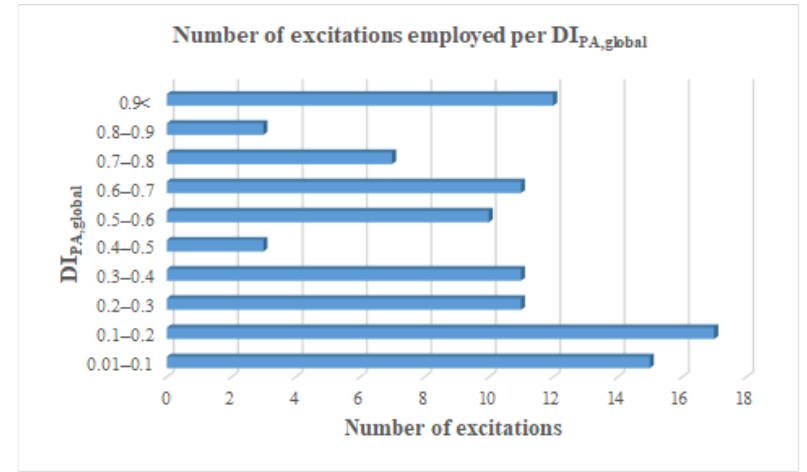
Figure 5. The number of excitations employed per DI PA,global range.